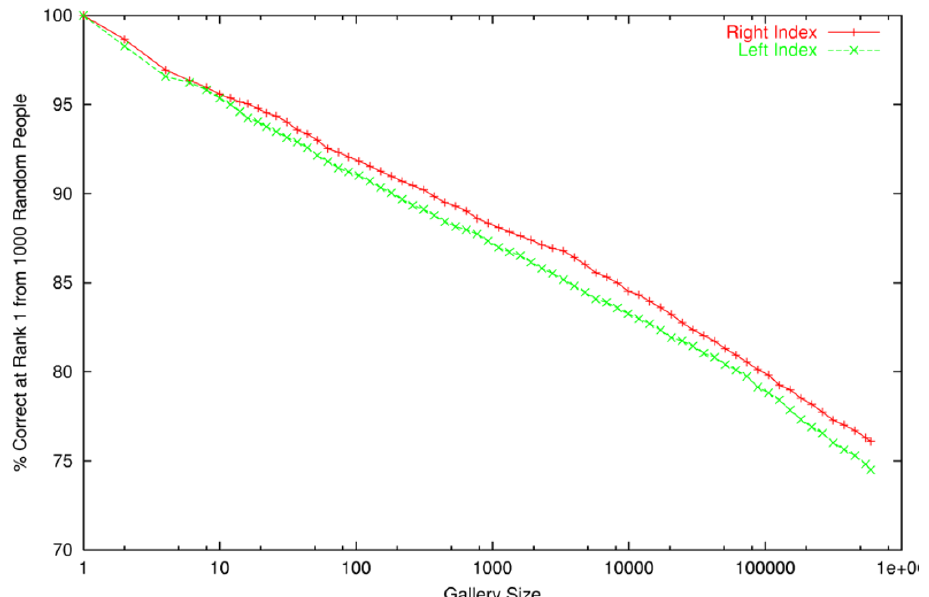
Figure 1. Probability of detection at Rank-1 IR as a function of more than 600,000 plain index fingers [1] (See Figure 19). Note the log scale for the x -axis. Probe set size was 1000 subjects. Fingerprint